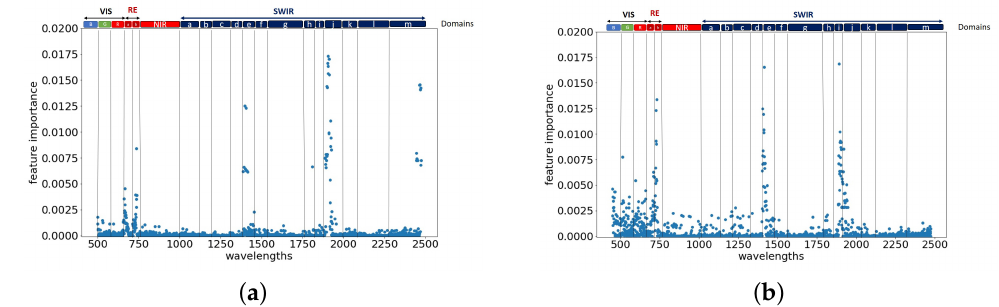
Figure 15. Feature importance (FI) calculated for each wavelength using the ExtraTrees Regressor method when considering only plots A and C (left) or plot B (right). The spectral domains defined in Table 6 are reported above the graph. ( a ) Plots A and C (RMSE = 0.14). ( b ) Plot B (RMSE =